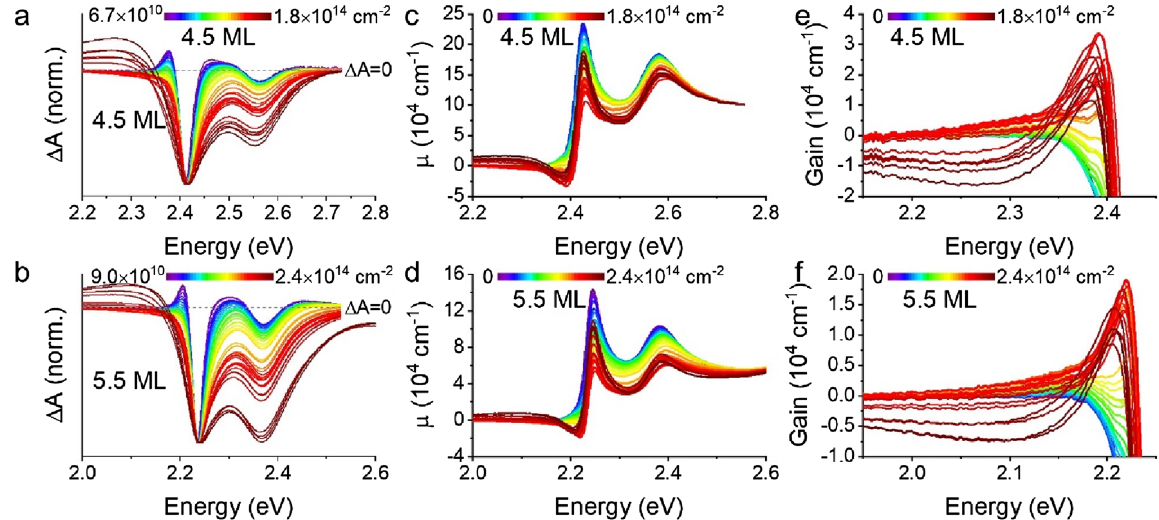
Figure 2. ( a , b ) Normalized transient absorption spectra (ΔA) of representative ( a ) 4.5 and ( b ) 5.5 ML CQW samples as a function of photogenerated sheet density. Each spectrum is collected at a 3 ps pump-probe delay for many powers of 3.5 eV pump light. ( c , d ) Linear absorption (cm −1 ) calculated for many photogenerated sheet densities of the same ( c ) 4.5 and ( d ) 5.5 ML samples. ( e , f ) Zoomed in regions of ( c ) and ( d ), respectively, showing the spectral window of